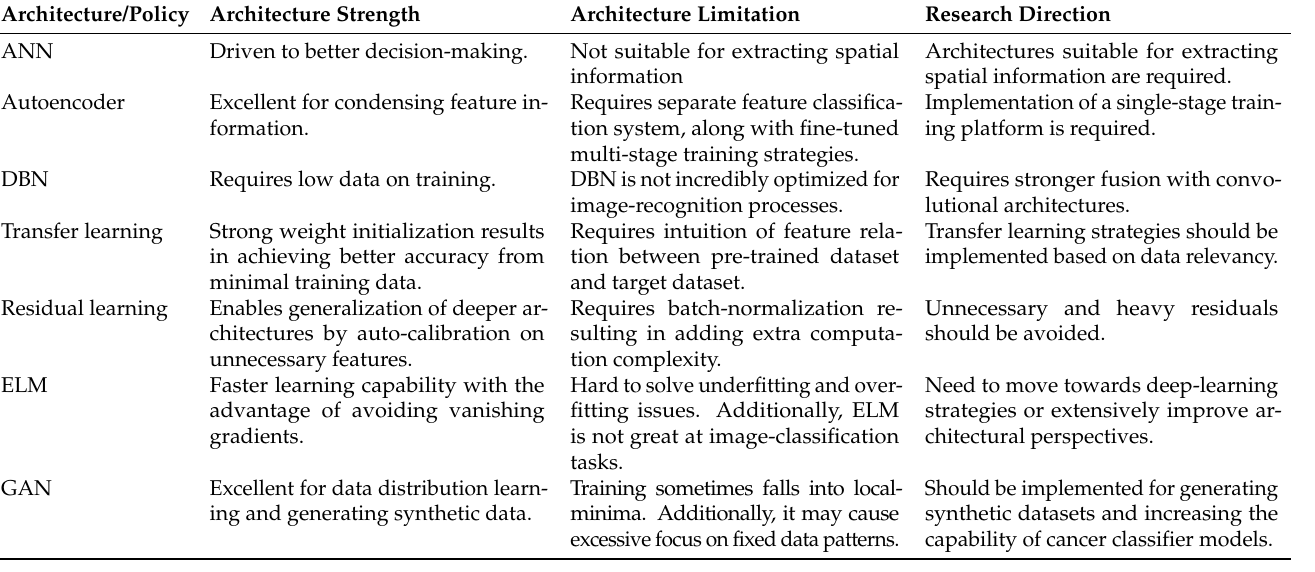
Table 13. A research directive for architectural selection for BrC